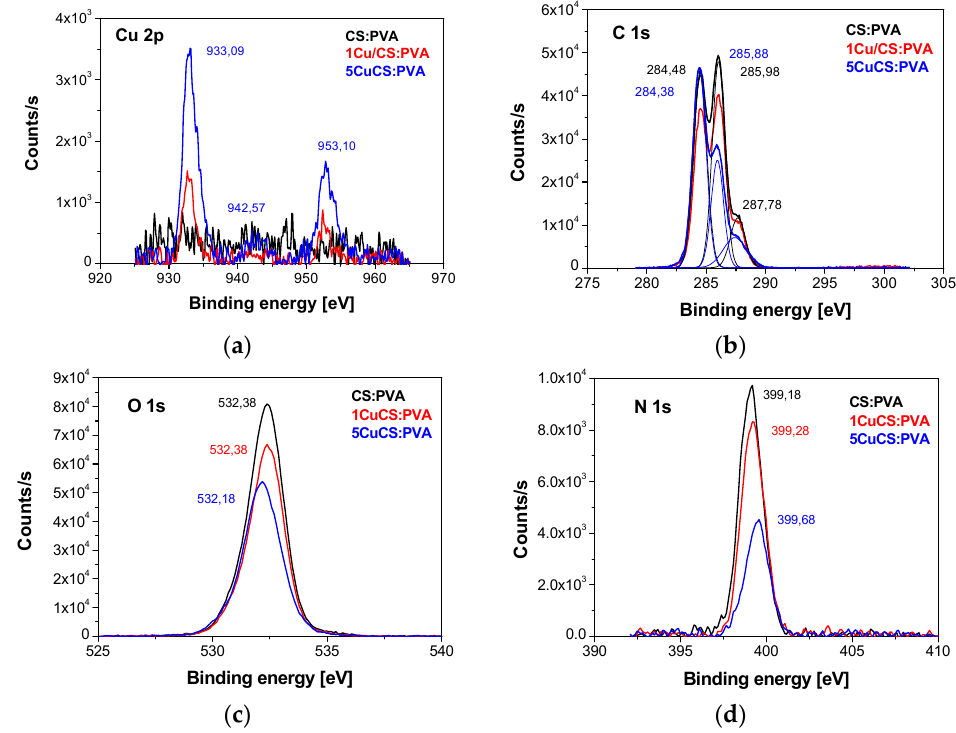
Figure 2. XPS spectra of Cu 2p ( a ); C 1s ( b ); O 1s ( c ) and N 1s ( d ) for the Cu/CS:PVA membranes.